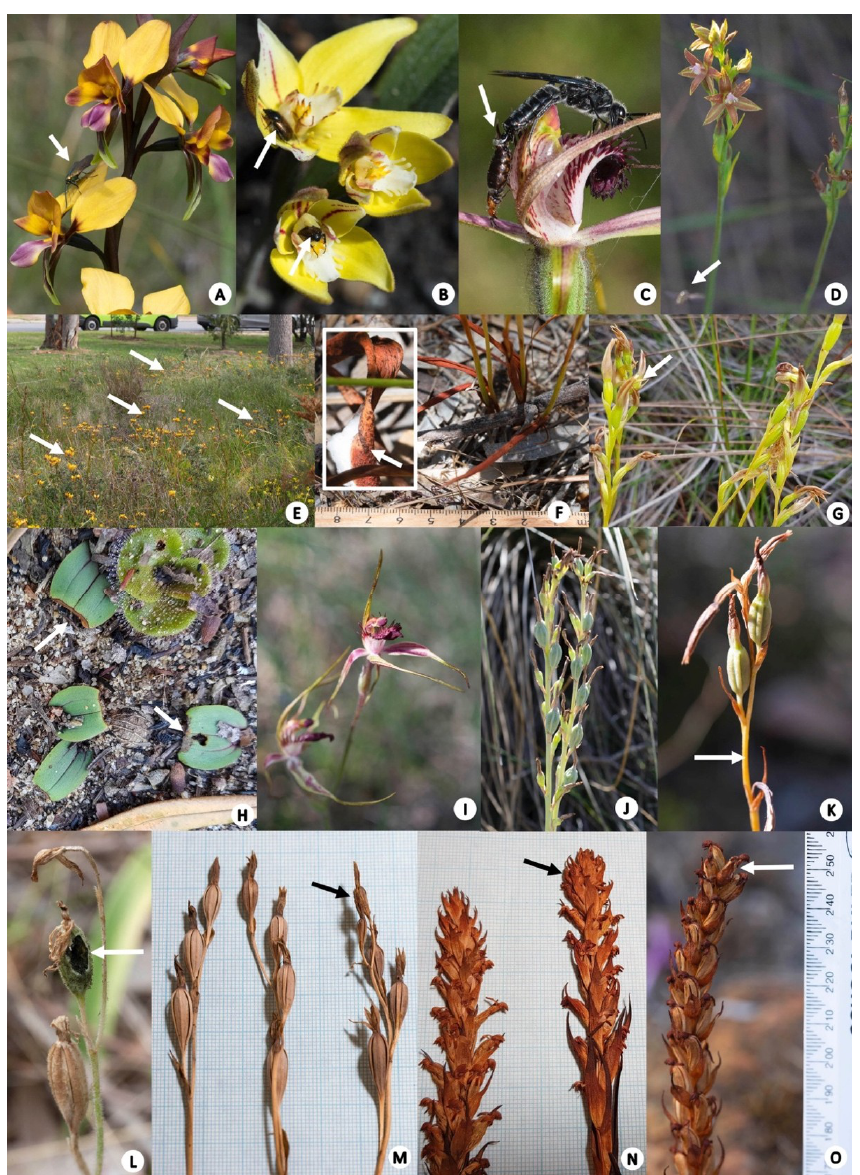
Figure 5. Observations of potential pollinators, habitats, threats and seed production from this study; ( A ) Diuris magnifica with forester moth ( Pollanisus sp., Zygaenidae—arrow); ( B ) Caladenia flava with nectar scarab beetles ( Phyllotocus sp.—arrows); ( C ) Caladenia arenicola and male thynnine wasp with attached female (arrow, Zaspilothynnus sp.); ( D ) Thelymitra fuscolutea with hoverfly ( Melangyna sp., Syrphidae—arrow); ( E ) The largest colonies of Diuris magnifica occurred in semi-disturbed areas; ( F ) Thelymitra fuscolutea leaves dried out before flowering; ( F Inset) Rust pustules on leaves; ( G ) Thelymitra fuscolutea with web of an insect that consumed seedpods (arrow); ( H ) Leporella fimbria leaves damaged by a fire (arrows); ( I ) Caladenia arenicola flower showing suspected virus symptoms; ( J ) Thelymitra macrophylla with multiple seedpods showing size gradation; ( K ) Thelymitra fuscolutea seedpod maturation while stem is dying (arrow); L. Caladenia latifolia seedpod grazing by an insect (arrow); ( M ) Thelymitra vulgaris upper seedpods (arrow) are smaller than lower seedpods; ( N ) Disa bracteata seed abortion in upper flowers (arrow) due to drought; ( O ) Well-watered Disa bracteata with seed formation from all flowers (arrow).